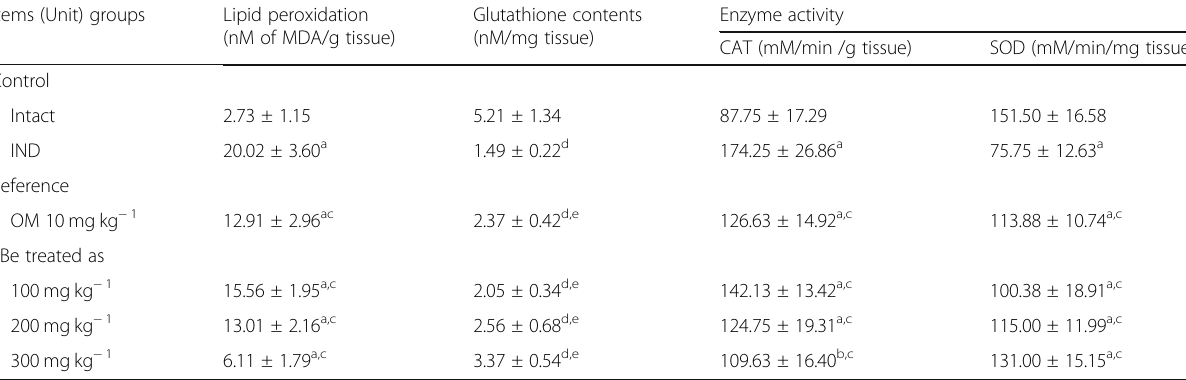
Table 2 Gastric lipid peroxidation, glutathione contents, CAT, and SOD activities in the intact or IND-treated rats Items (Unit) groups